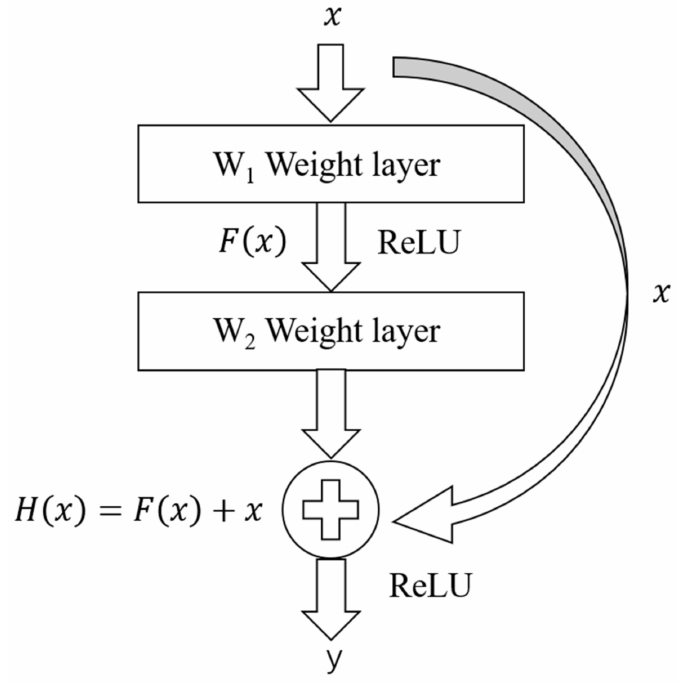
Figure 2. The residual